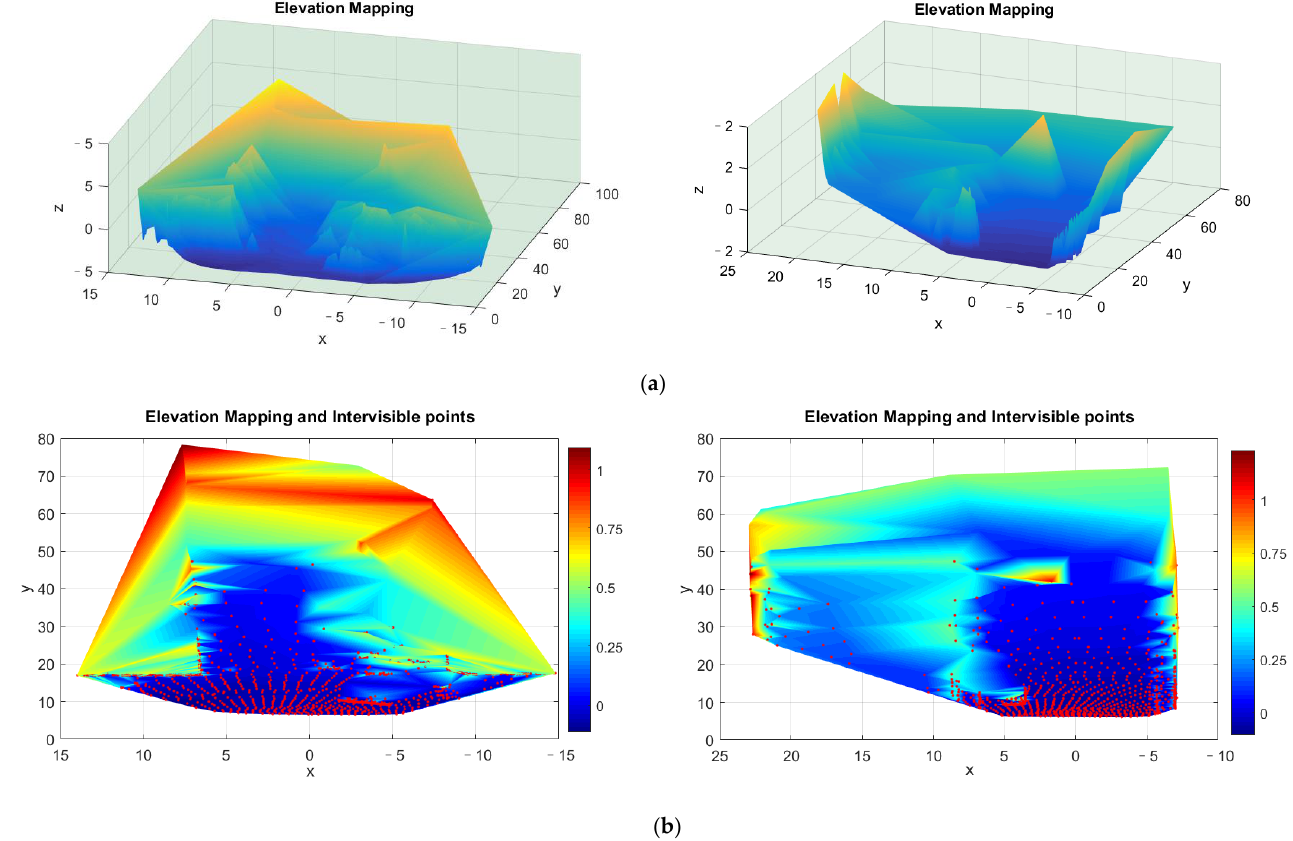
Figure 8. Intervisibility terrain mapping results in FOV. ( a ) 3D view; ( b ) Top view.